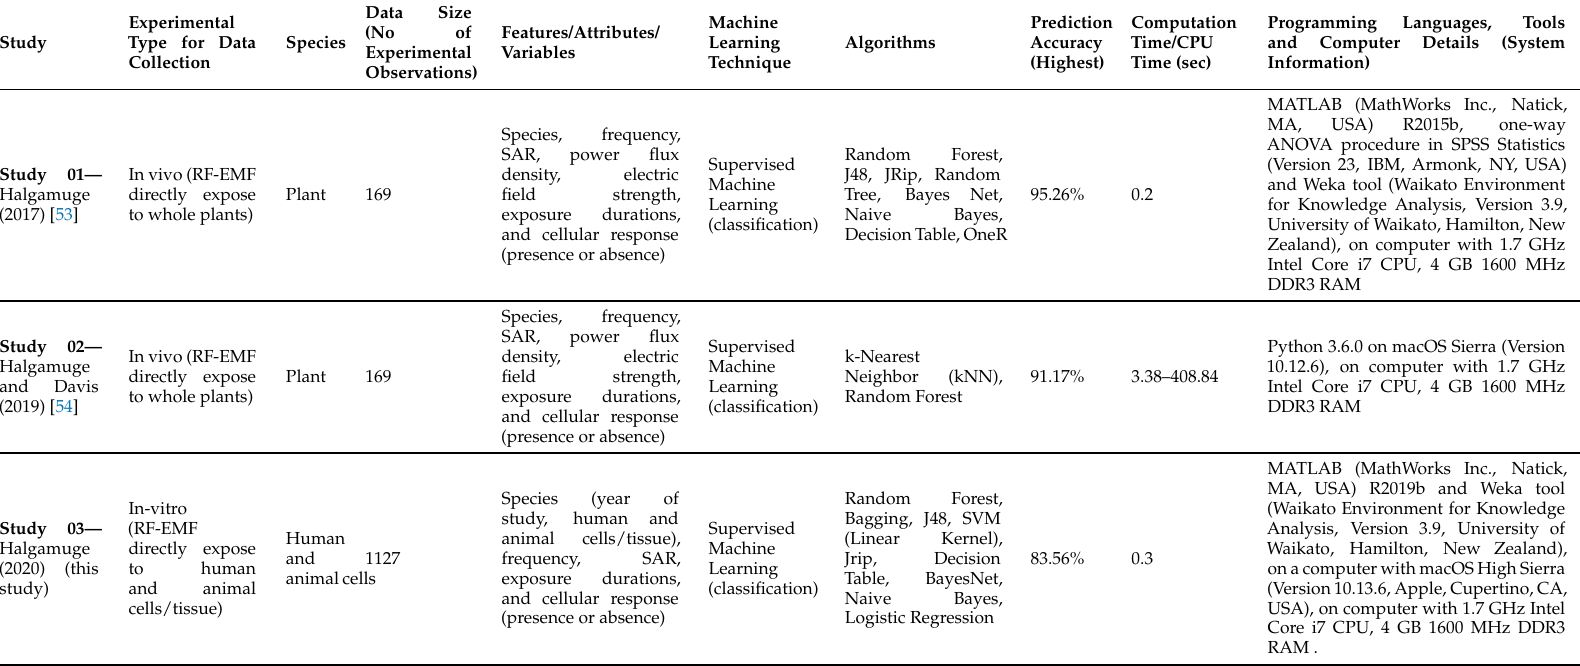
Table 1. Supervised machine learning algorithms for in-vitro studies in Bioelectromagnetics: weak radiofrequency electromagnetic fields (RF-EMF) on living organisms.